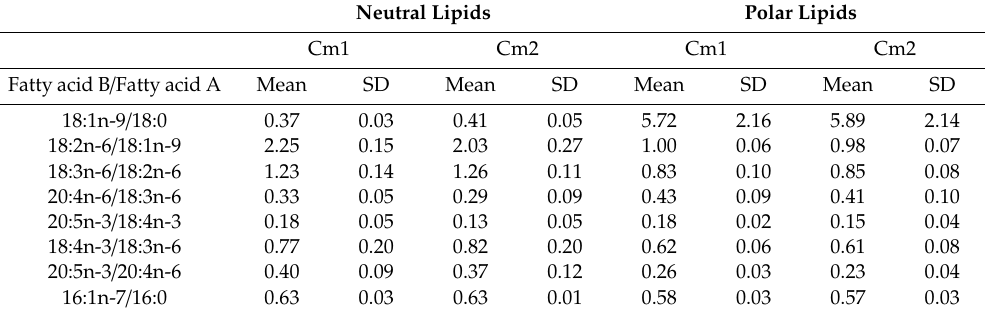
Table 4. Mean ratio of atomic enrichment (AE) for pairs of FA (FA A vs. FA B ) in neutral lipids (NL) and polar lipids (PL) (Mean ± SD, n = 10 sampling dates) for the two enriched balloons (Cm1, Cm2; Cm = Chaetoceros muelleri ). If the ratio is equal to or close to 1, A and B are assumed at equilibrium, and B is synthesized quickly from A; if the ratio is below 1, the transformation of B from A is possible but slow. Finally, if the ratio is above 1, A is not the main precursor of B, which has to be synthesized by a different pathway. Neutral